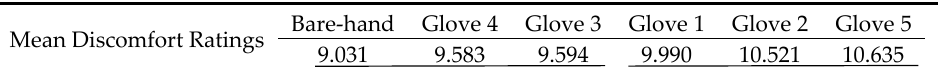
Table 8. Post hoc comparisons for glove type plus bare-hand. *